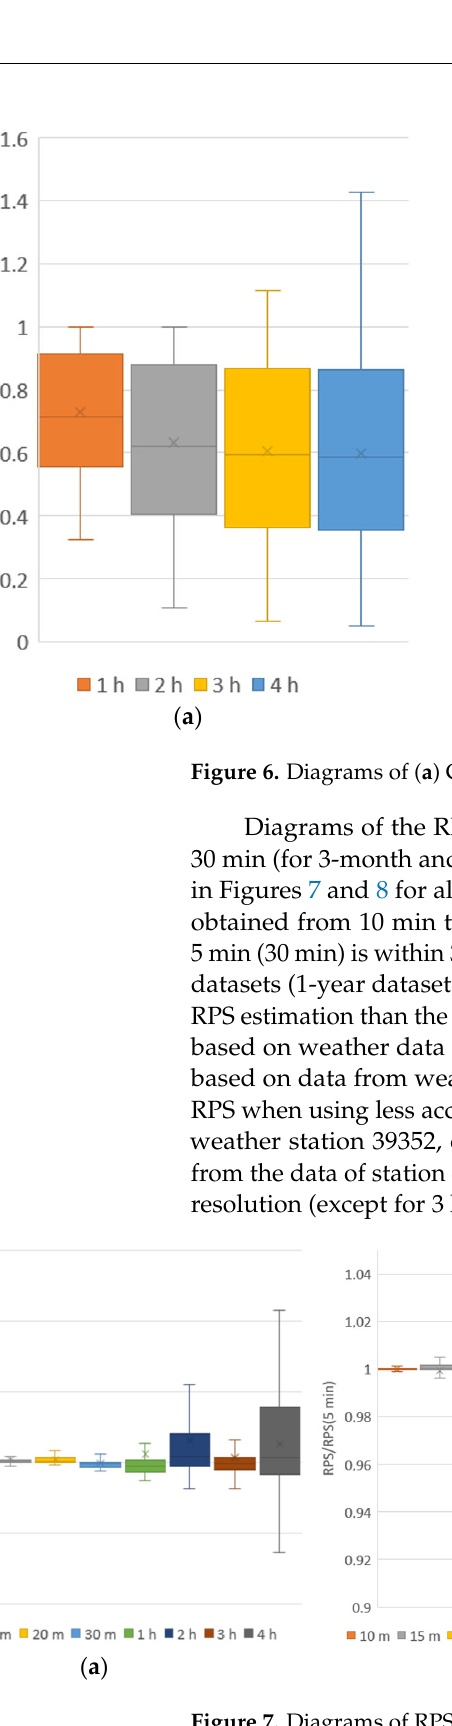
( c ) Figure 8. Diagrams of RPS for ( a ) 23005, ( b ) 39352 and ( c ) 47647 station ID’s. One ‐ year datasets. 4. Discussion There are quite certain trends in the dependence of the calculation results of the main characteristics of the power supply system performance and its cost on the reduction of the weather data temporal resolution (relevant both for 3 ‐ month and 1 ‐ year data sets as the temporal resolution decreases): 